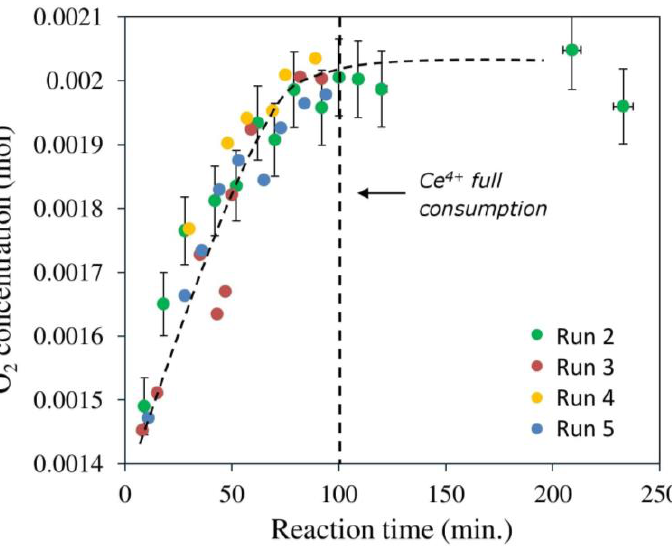
Figure 11. Repeated O 2 production as function of time using 4 wt.% IrO 2 /TiO 2 and Ce 4+ cations as electron scavengers (0.182 Mol). Error bars are added on the first experiment only (but are similar for the remaining three runs). The lines are visual guides.